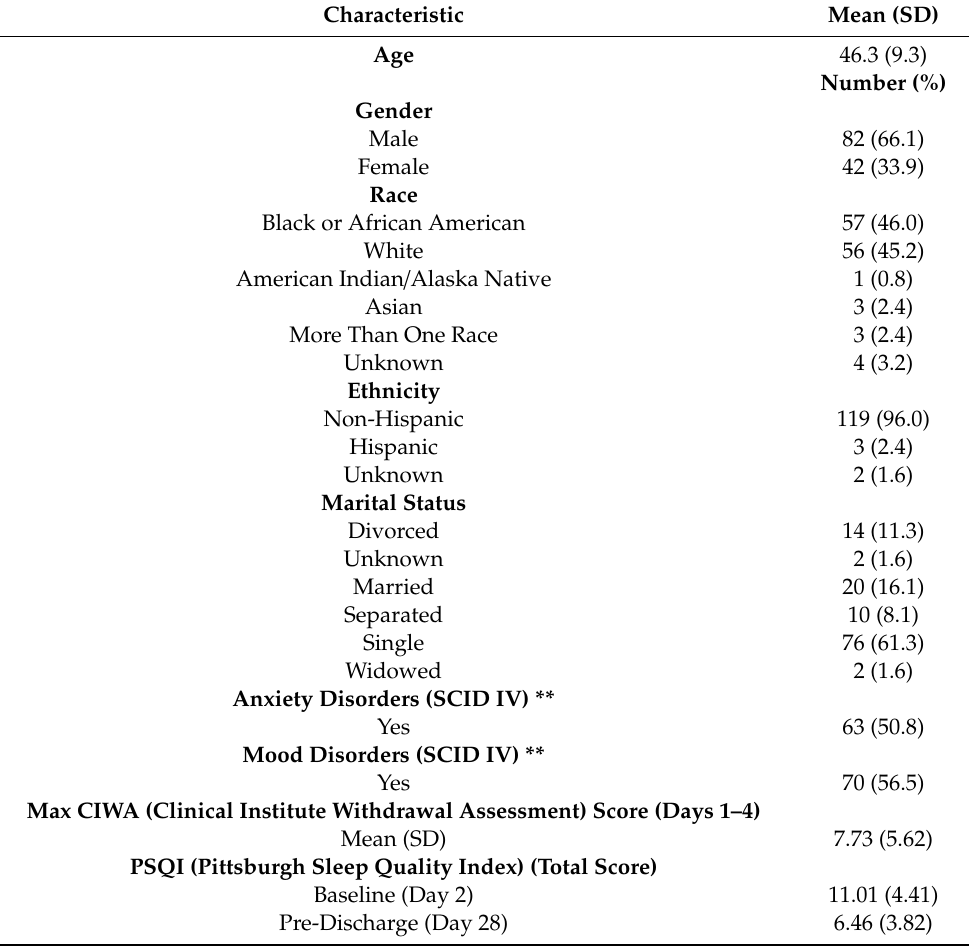
Table 1. Demographic, clinical and sleep variables (N = 124